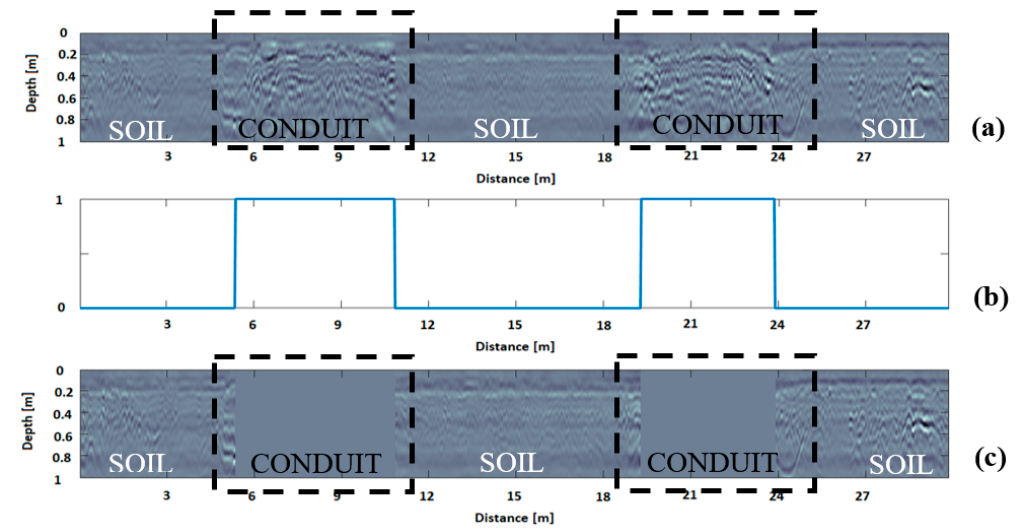
Figure 11. An example of the GPR reflectivity analysis. ( a ) B-scan after the preliminary signal processing stage, ( b ) analysis of the signal reflectivity, showing a maximum value at the section coordinates of the identified buried feature, and ( c ) B-scan after a targeted trace removal.